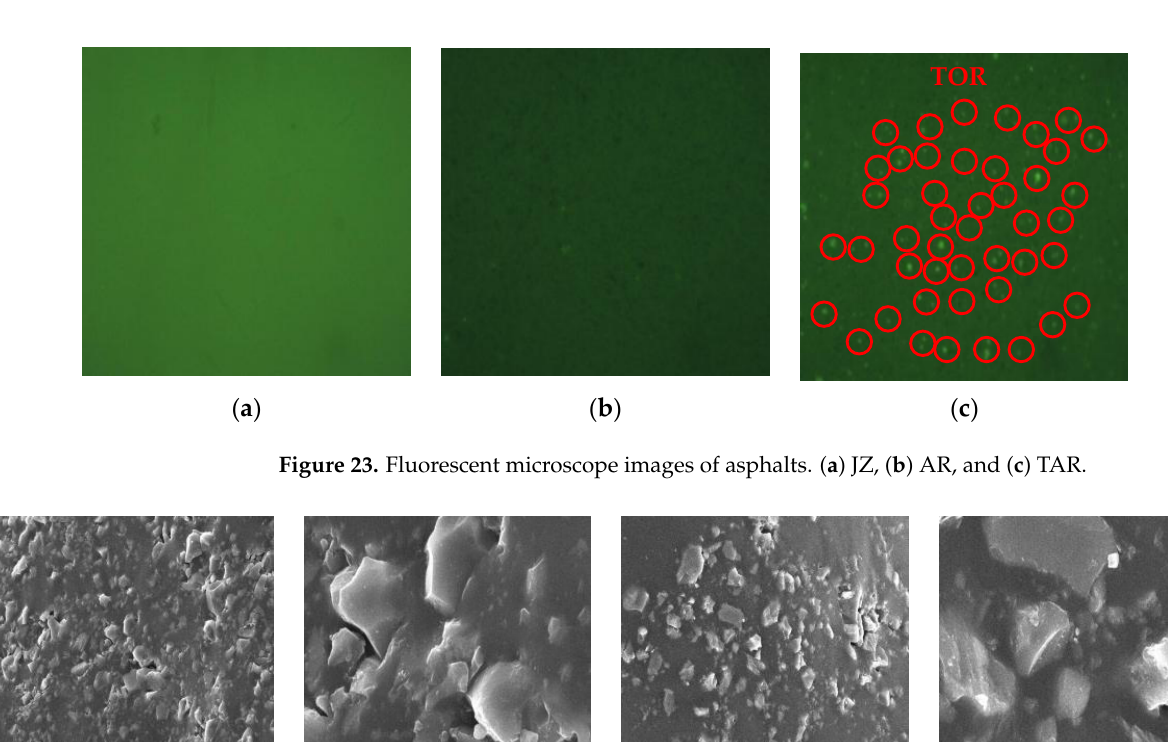
( b ) Figure 22. The variations of J ’ (t) at different temperatures. ( a ) JZ ( b ) AR and TAR. In Figure 22, with the increase in loading time, J ’ (t) values gradually decrease and eventually tend to be stable. Therefore, the longtime load makes the low temperature crack resistances of asphalts tend to be stable, and the low temperature performances of three kinds of asphalts are no longer affected by the load action time. When the loading time is short, the J ’’ (t) values of the same asphalt decrease with the decrease in tempera- ture. When the temperature is low, J ’ (t) values tend to be stable, indicating that tempera- ture has the most significant effect on the low temperature performances of three kinds of asphalts. Based on viscoelastic theory and BBR creep test, the low temperature performances of JZ, AR, and TAR were evaluated and analyzed by m and S values, dissipated energy ratio, m/s value, and creep compliance derivative. The results of the four evaluation meth- ods are consistent. The low temperature performances of the three kinds of asphalts are AR > TAR > JZ. 4. Microscopic Mechanism Analysis Figure 23 shows fluorescence microscope images of three kinds of asphalts. The JZ is green-yellow. The additions of crumb rubber and TOR cause the color to deepen, so AR and TAR are dark green. The crumb rubber particles are black without fluorescence, and evenly disperse in the asphalt. TOR particles have no fluorescence effect and appear white. TOR particles evenly disperse in black crumb rubber particles – asphalt system. By